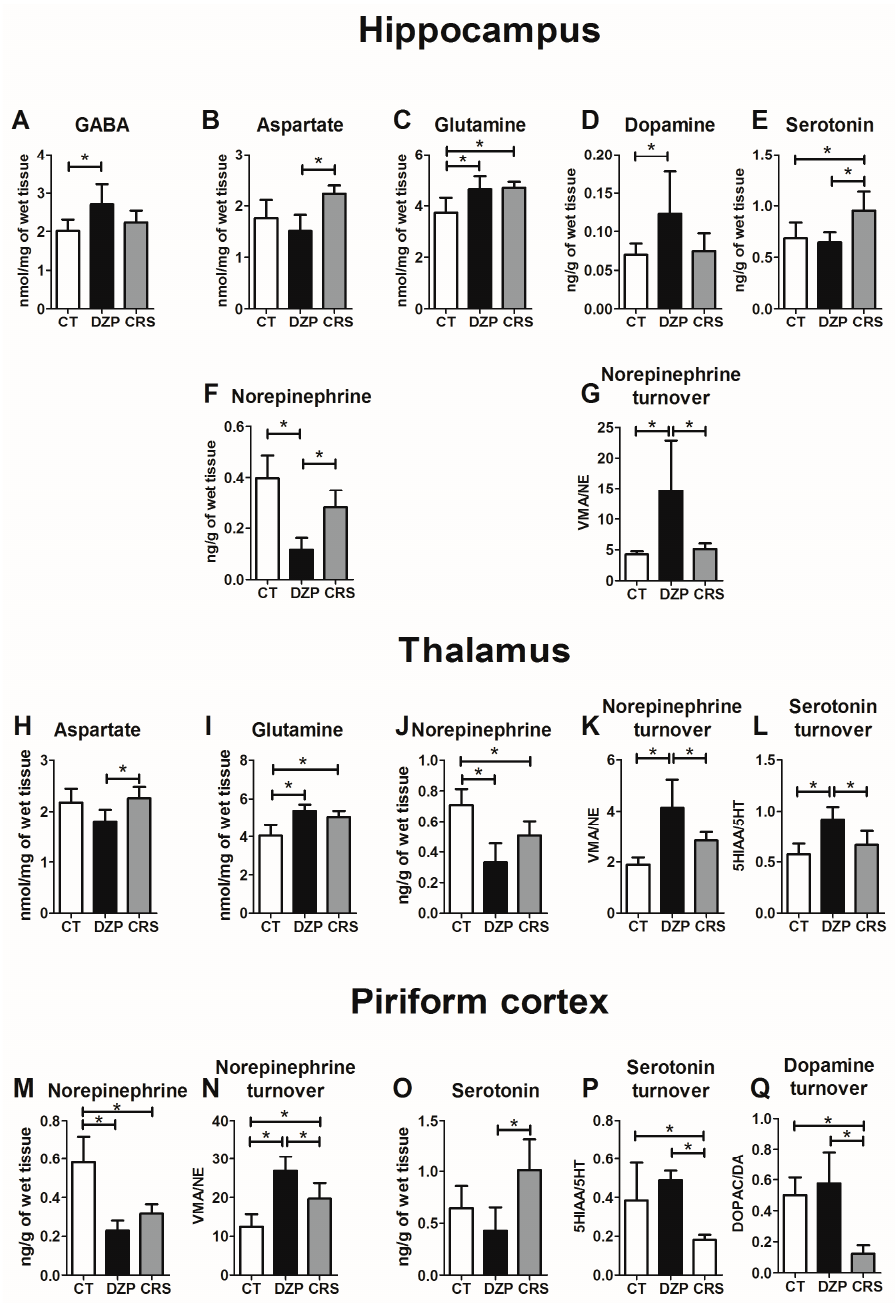
Figure 2. Effect of SE and CRS treatment on monoamine and amino acid levels in the